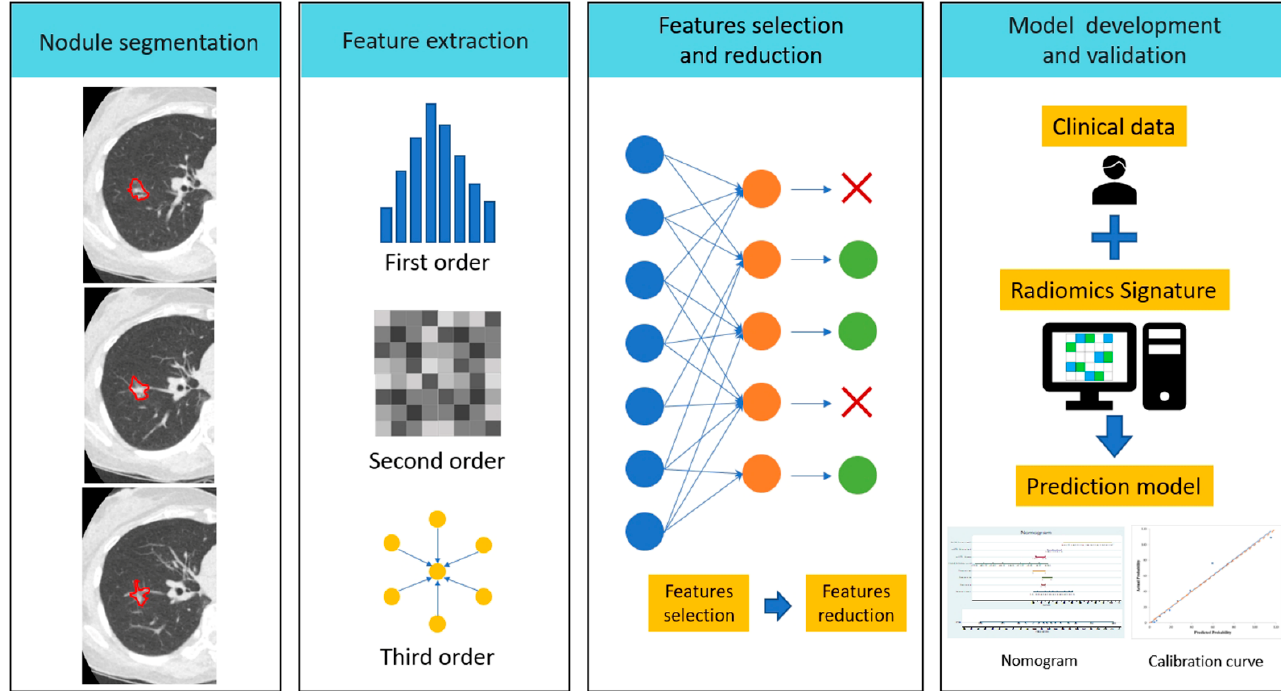
Figure 1. The workflow of radiomics analysis in early lung cancer diagnosis. Because lung nodules in early-stage lung cancer usually manifest with ground-glass or part-solid nodules, automatic nodular contour segmentation is usually not accurate. The manual approach to ROI analysis for early lung cancer diagnosis is highly demanding in terms of time and radiomics expertise.